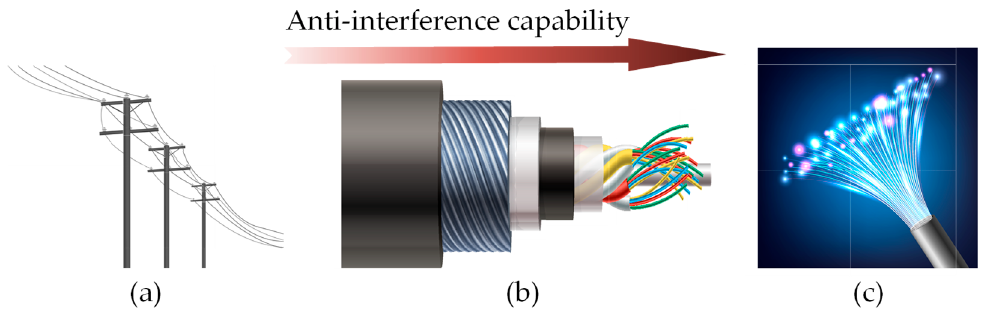
Figure 2. Communication lines: ( a ) Overhead open-wire lines; ( b ) Sheilded aerial/buried cables; ( c ) Optical fiber.